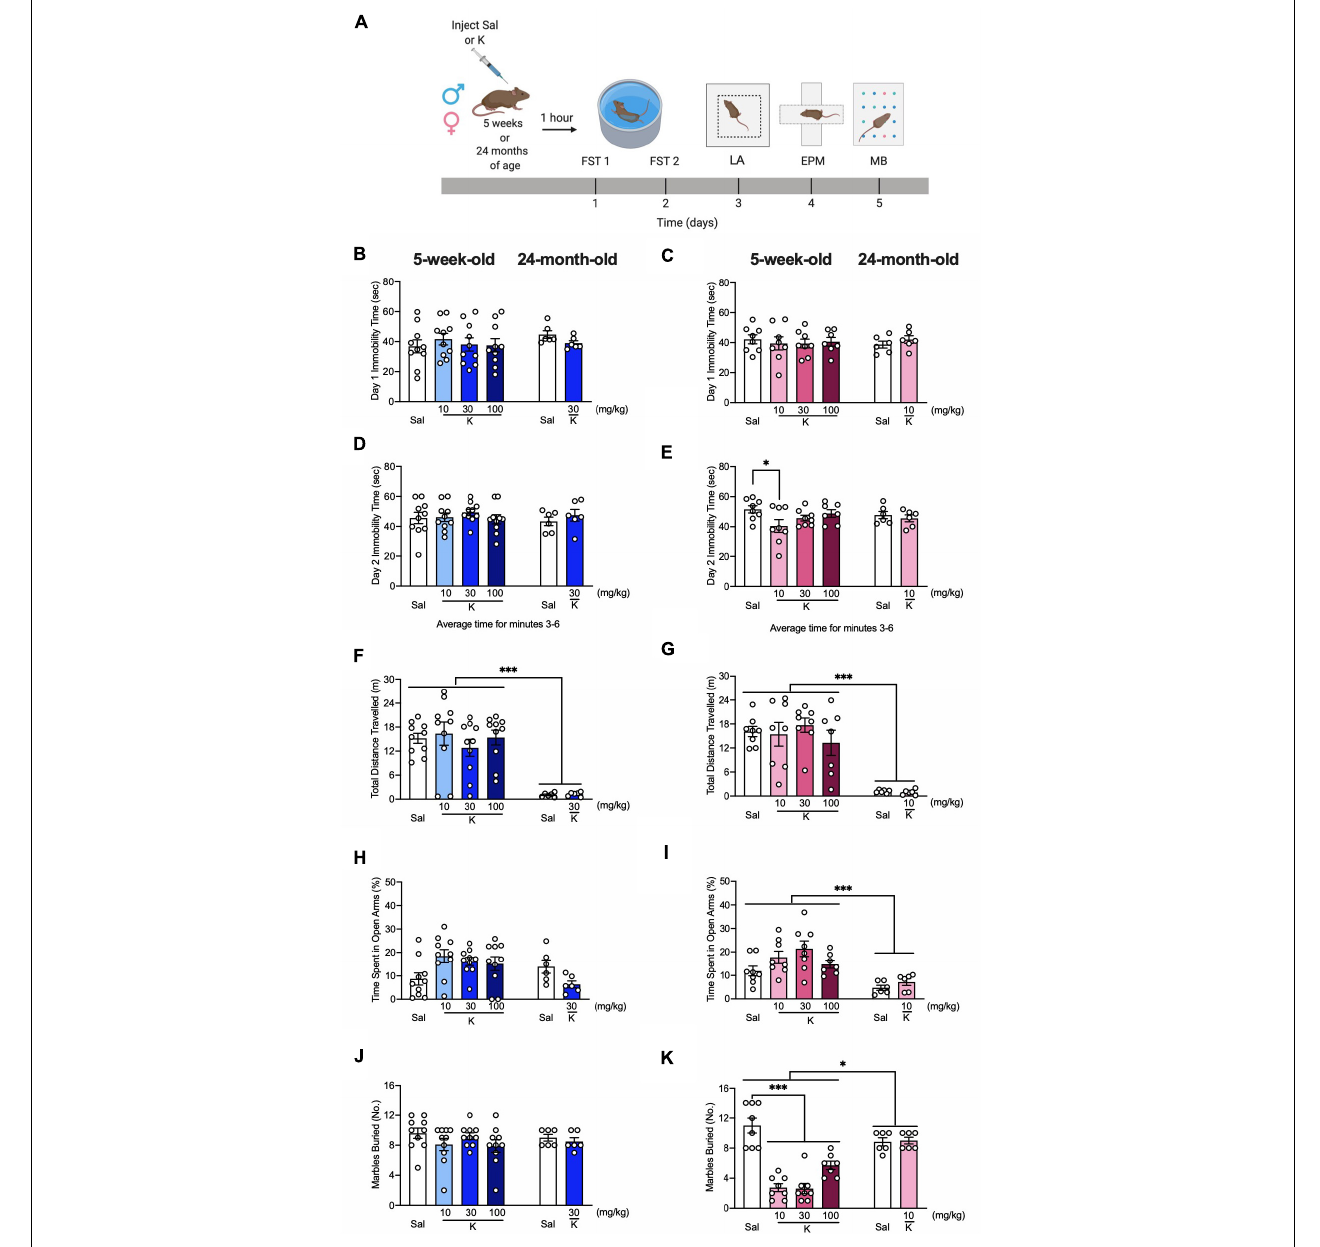
FIGURE 1 | Acute ( R,S )-ketamine administration decreases behavioral despair and perseverative behavior in adolescent female, but not male mice. (A) Experimental design. (B) Five-week-old male mice administered saline or ( R,S )-ketamine exhibited similar immobility time to 24-month-old male mice on day 1 of FST. ( R , S )-ketamine did not impact immobility time in any groups of male mice. (C) Five-week-old and 24-month-old female mice administered saline or ( R,S )-ketamine exhibited similar immobility time on day 1 of FST. ( R , S )-ketamine did not impact immobility time in any groups. (D) All groups of 5-week-old and both groups of 24-month-old male mice had comparable immobility time on day 2 of the FST. (E) Five-week-old female mice administered ( R , S )-ketamine (10 mg/kg) exhibited reduced immobility time when compared with female mice administered saline. Both groups of 24-month-old female mice had comparable immobility time on day 2 of the FST. (F,G) ( R,S )-ketamine did not affect the distance traveled in the LA in 5-week-old and 24-month old male and female mice. However, 24-four-month-old male and female mice traveled significantly less than 5-week-old mice. (H) Five-week- and 24-month-old male mice spent a comparable time in the open arms. (I) Five-week-old female mice spent a more time in the open arms than 24-month-old female mice. ( R , S )-ketamine did not impact behavior in any groups. (J) During the MB task, all groups of male mice buried a comparable number of marbles. (K) All groups of 5-week-old female mice administered ( R , S )-ketamine buried significantly fewer marbles when compared with female mice administered saline. Five-week-old female mice buried significantly fewer marbles than 24-month-old female mice. Both groups of 24-month-old female mice buried a comparable number of marbles. ( n = 6–10 mice per group). Error bars represent ± SEM. ∗ p < 0.05. ∗∗∗ p < 0.0001. Sal, saline; K, ( R,S )-ketamine; FST, forced swim test; LA, locomotor activity test; EPM, elevated plus maze; MB, marble burying; sec, second; mg, milligram; kg, kilogram; m, meter; No, number.